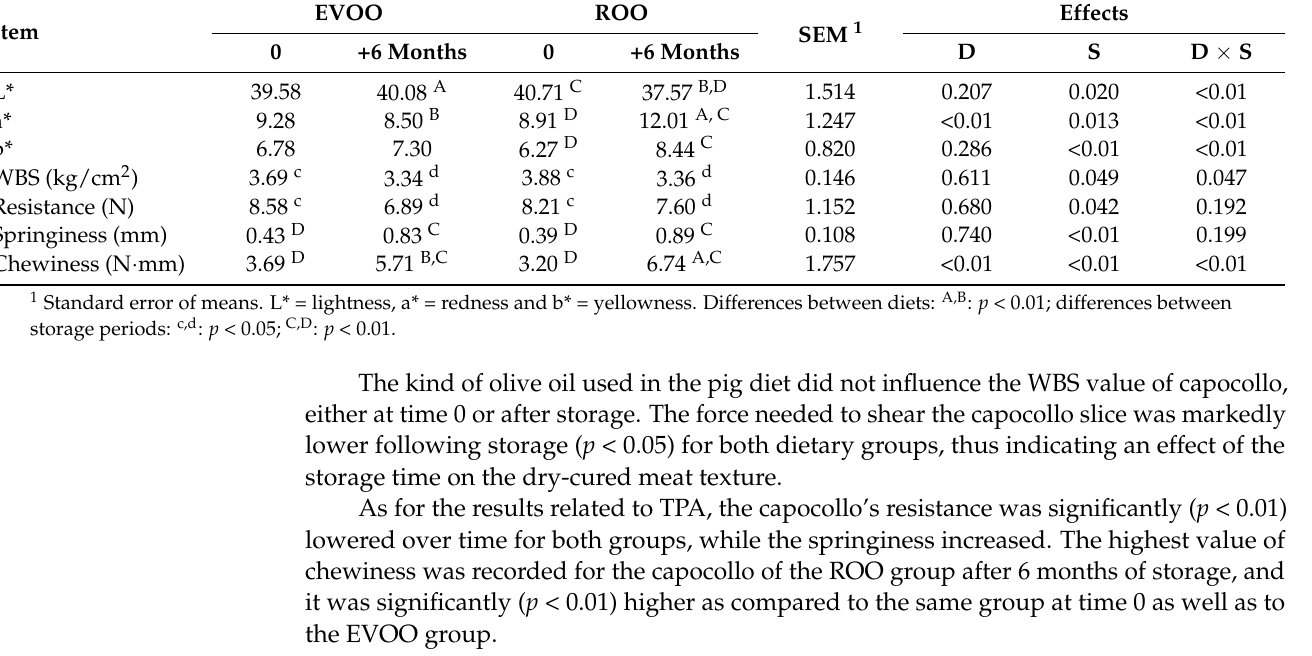
Table 4. Effect of the pig diet (EVOO and ROO) and of the storage period (0 and +6 months) on the physical traits of Capocollo di Martina Franca dry-cured meat.